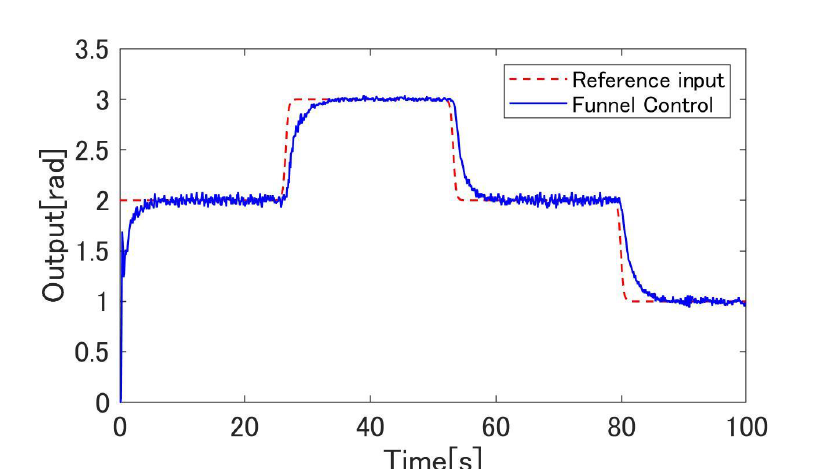
Figure 20. The output angle θ of the proposed